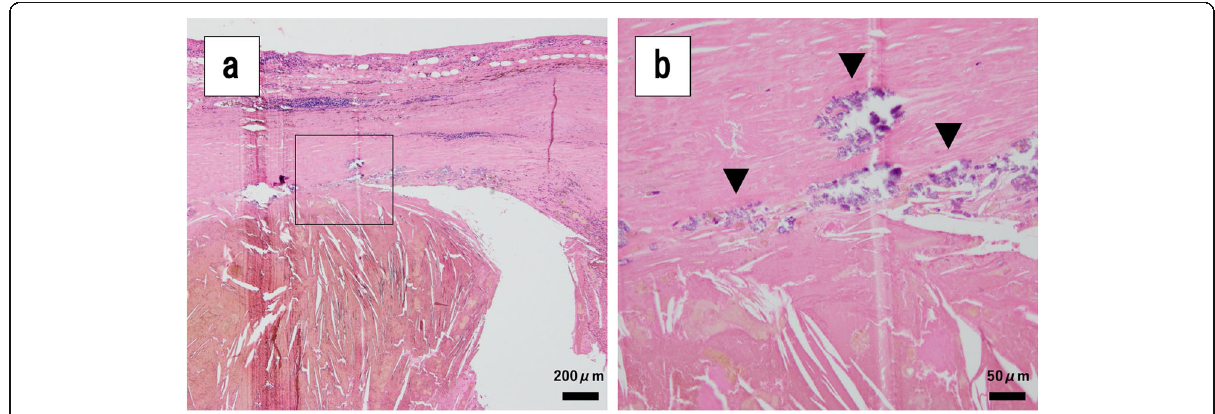
Fig. 2 Pathological findings. a , b The tumor was surrounded by a fibrous capsule, containing massive hemosiderin deposits and cholesterol crystals showing partial calcification (arrowhead). The cystic wall contained no elastic fibers, vessels, or epithelial cells, indicating it was a pseudocyst. The tumor was located in mesenteric fat tissue and in the jejunal serosa, with no atypical cells at the jejunal mucosal